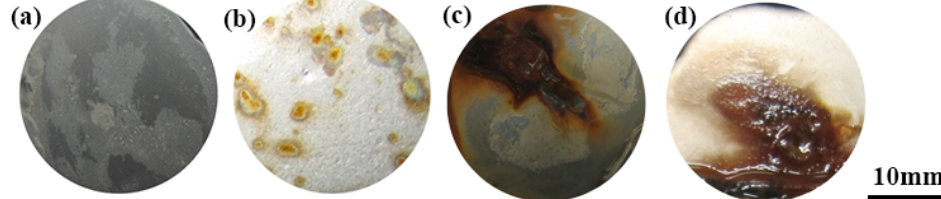
Figure 10. Morphology of two kinds of stainless steels after salt spray corrosion of ion nitriding samples for 360 h under different conditions: ( a ) 300 °C for 24 h (1Cr15); ( b ) 300 °C for 48 h (1Cr15); ( c ) 300 °C for 24 h (17-4PH); ( d ) 300 °C for 48 h (17-4PH).